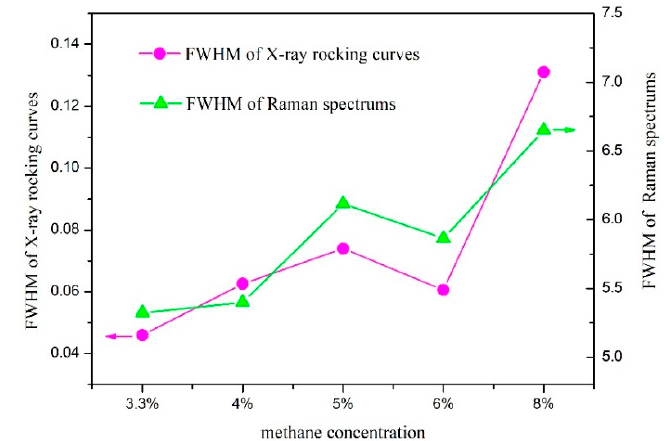
Figure 7. The FWHMs of X-ray rocking curves and Raman spectra of as-grown diamond films with methane concentration varying from 3.3% to 8%.